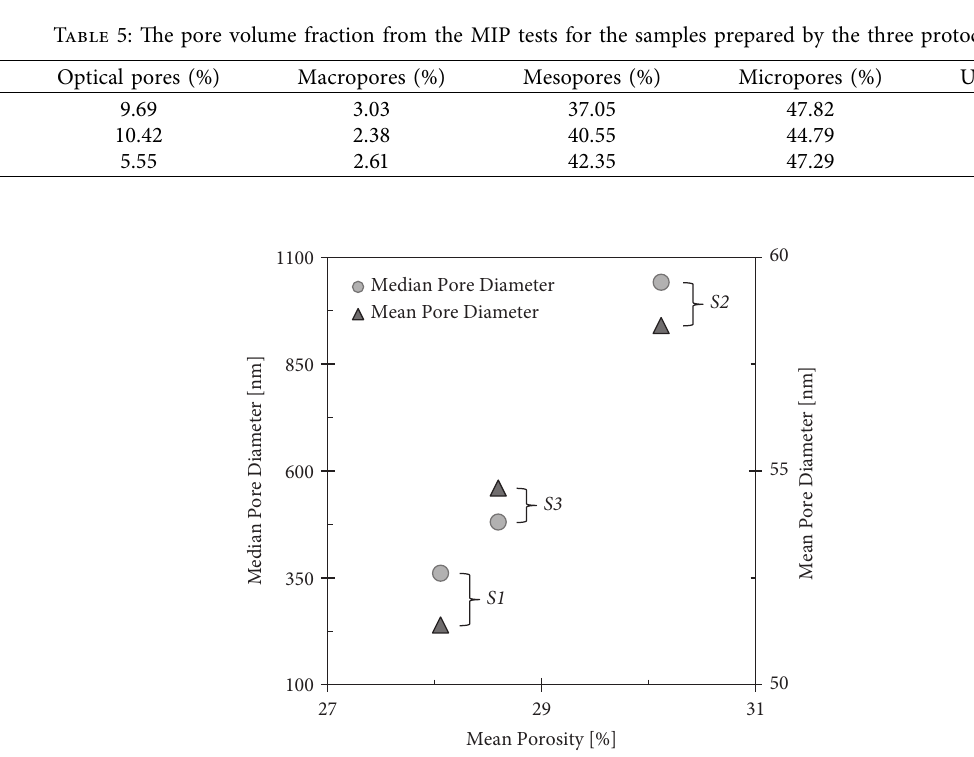
Figure 9: Median and mean pore size as a function of the mean porosity for samples prepared by S1, S2, and S3